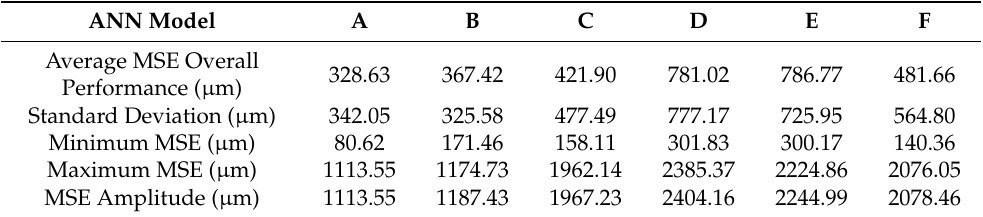
Table 8. Comparison between the standard deviation for average, minimum and maximum MSE values for all models from A to F.